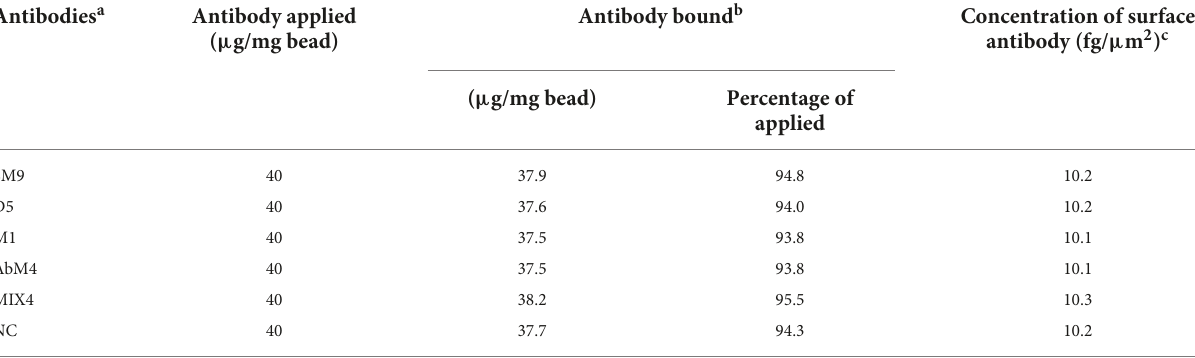
TABLE 2 Antibody binding to